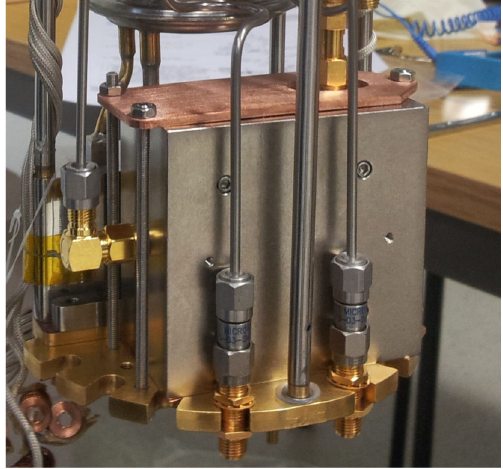
FIG. 2. A standard Faraday circulator mounted in a low- temperature experiment. The circulator, with its enclosing mag- netic shield, is contained in the rectangular steel-colored box (dimensions 6 × 6 × 3 cm 3 ). This circulator is designed for an operating frequency of 400 MHz, those in use for GHz-band experiments are somewhat more compact. Another interesting view of microwave circulators in action in a multiqubit experi- ment can be found in Ref. [3]. In the present paper, we propose a scheme for achieving a passive circulator with a physical scale 10 – 100 times smaller. As in the present-day circulator, significant magnetic fields (perhaps approaching tesla scale) will be re- quired. This will require a shield structure as in the device shown, but again